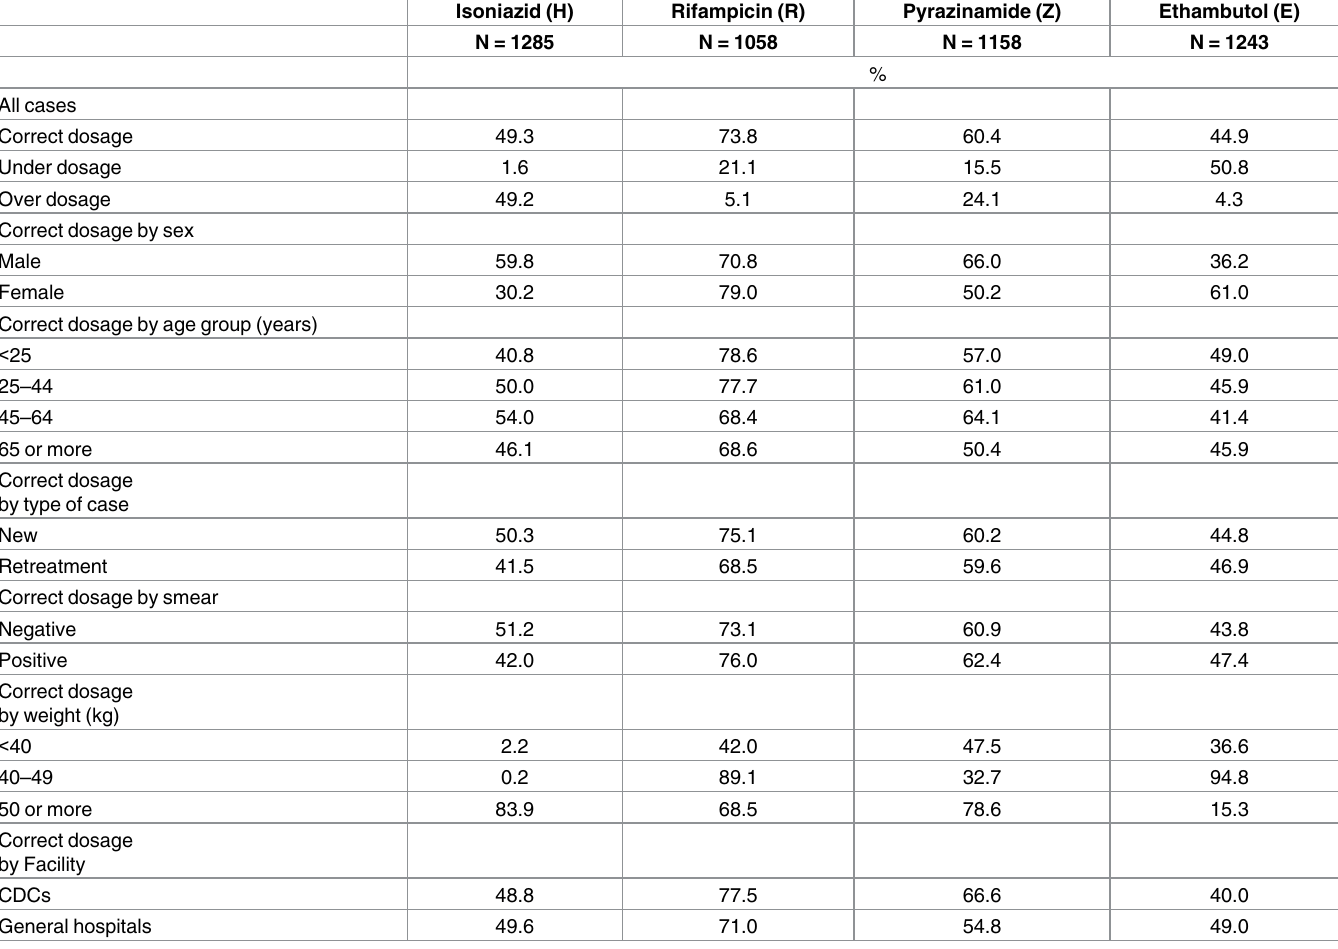
Table 6. Proportion of patients with correct,under, and over dosages of anti-tuberculosis drugs prescribeaccording to dosage in mg per kg body weight recommended by WHO. Isoniazid